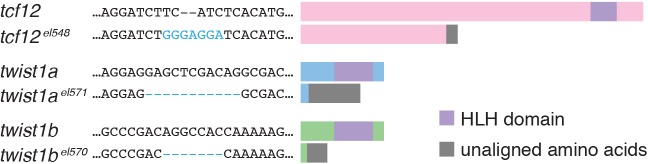
Zebrafish TALEN mutants.The sites of nucleotide changes induced by TALEN cleavage are shown for each mutant allele. Schematics show the predicted protein truncations caused by the frame-shift mutations, relative to the DNA-binding basic helix-loop-helix domain (HLH, purple).